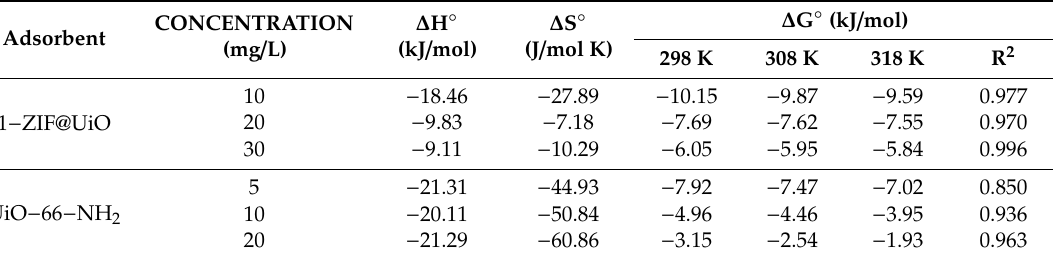
Table 6. Values of the thermodynamic